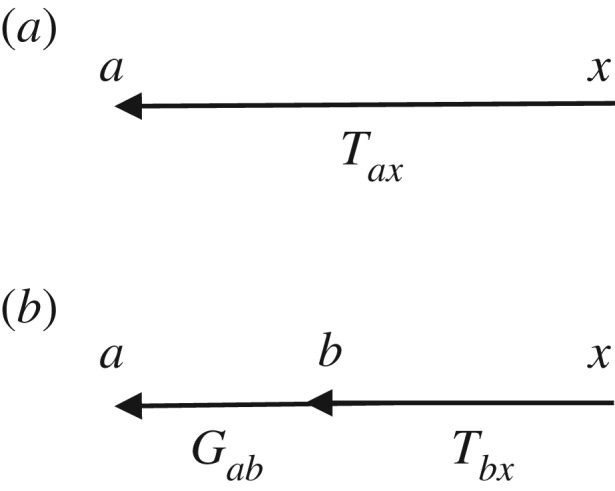
Diagrammatic representation of the propagator and its decomposition. (a) Full propagator Tax. (b) Decomposition into a sum of terms GabTbx to be summed over all populations b that project to a, including b = a where there are self-projections.